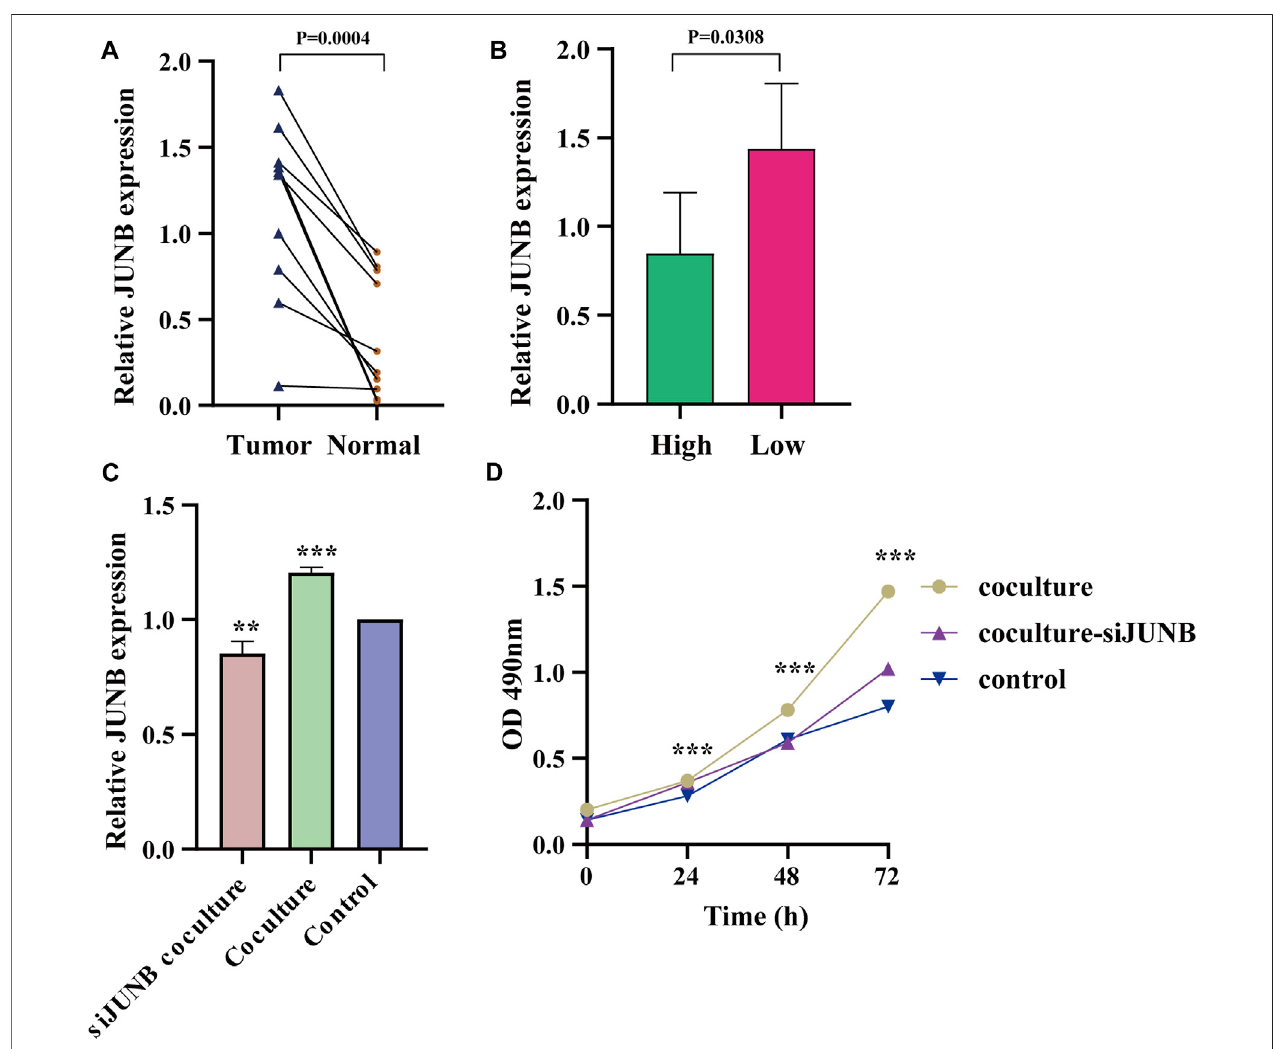
FIGURE 8 | CAFs promoted bladder tumor proliferation by JUNB. (A,B) The expression of JUNB between bladder tumor and adjacent normal tissues (A) , and high- and low-immunity group (B) , by qRT-PCR analysis. (C) The expression of JUNB after JUNB knockdown, under co-culture conditions. (D) T24 cell viability when co-cultured with